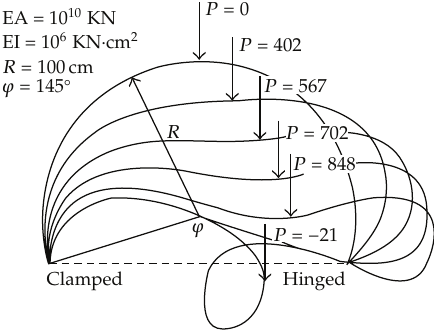
Figure 4: Circular arc geometry and deformed shape in some di ff erent load